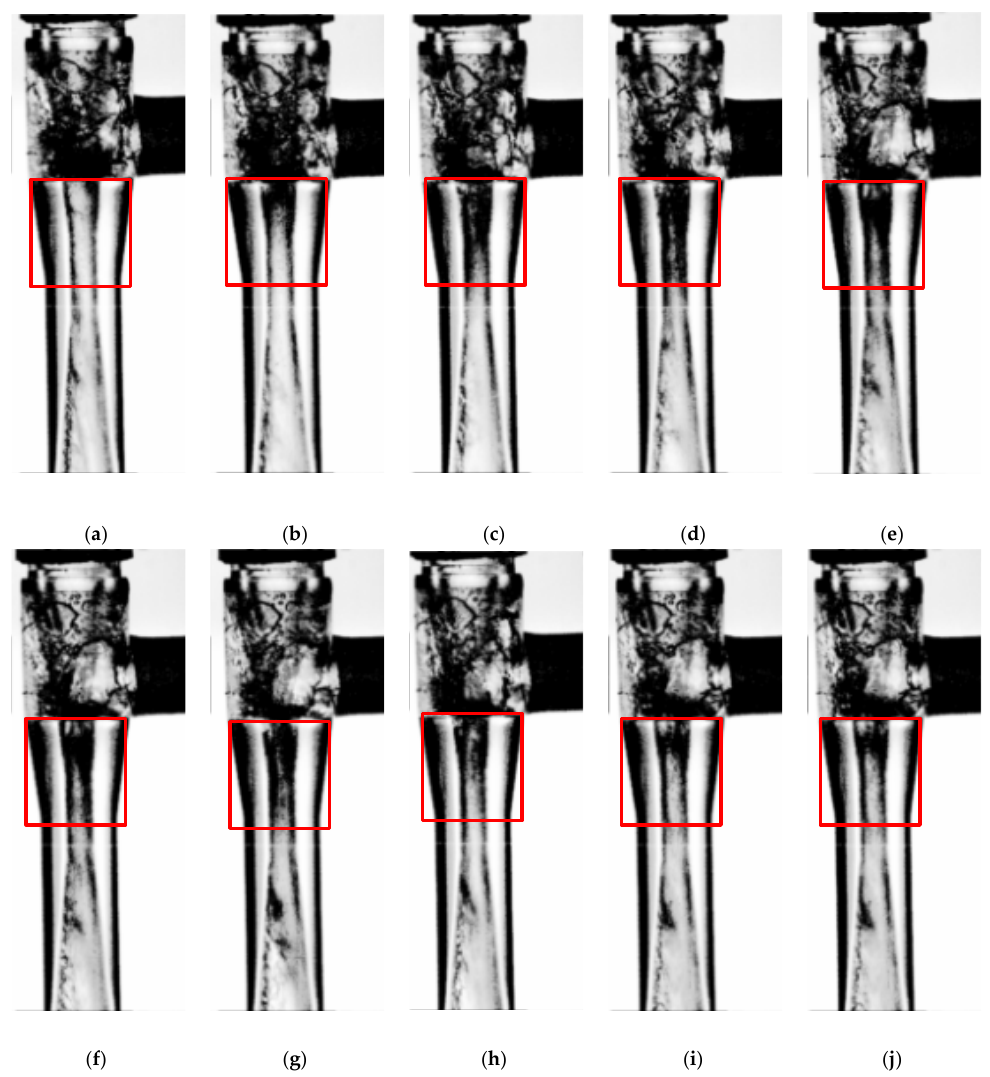
Figure 11. Gas–liquid mixing pulsating phenomenon of suction chamber images at critical point. ( a ) 47 ms; ( b ) 48 ms; ( c ) 49 ms; ( d ) 50 ms; ( e ) 51 ms; ( f ) 52 ms; ( g ) 53 ms; ( h ) 54 ms; ( i ) 55 ms; ( j ) 56 ms.